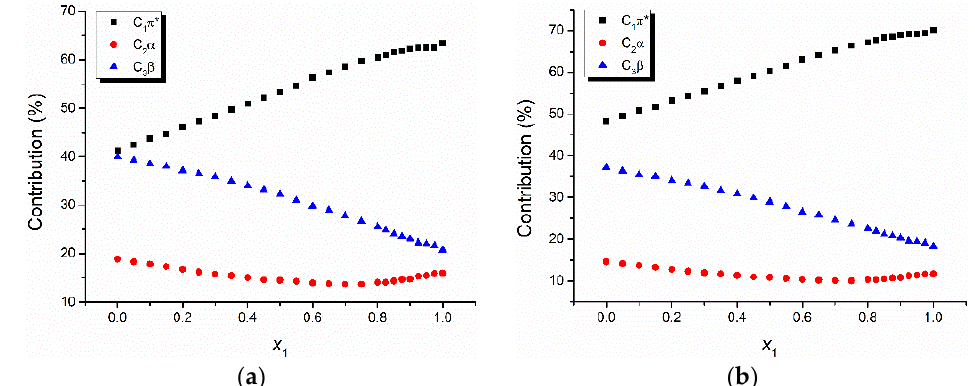
Figure 4. The contribution (percentage) to the spectral shift of universal and specific interactions for 4-tolyl-1,2,4-triazol-1-ium phenacylid (TTPY) ( a ) and 4-tolyl-1,2,4-triazol-1-ium-4 ’ -nitro-phenacylid (TTNPY) ( b ) in binary solvent mixture water + methanol.